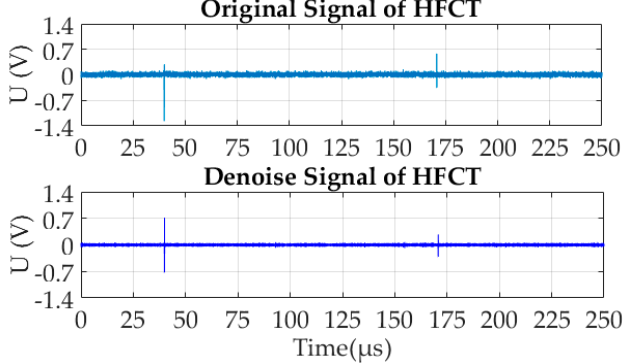
Figure 6. Original signal and denoise signal of HFCT.